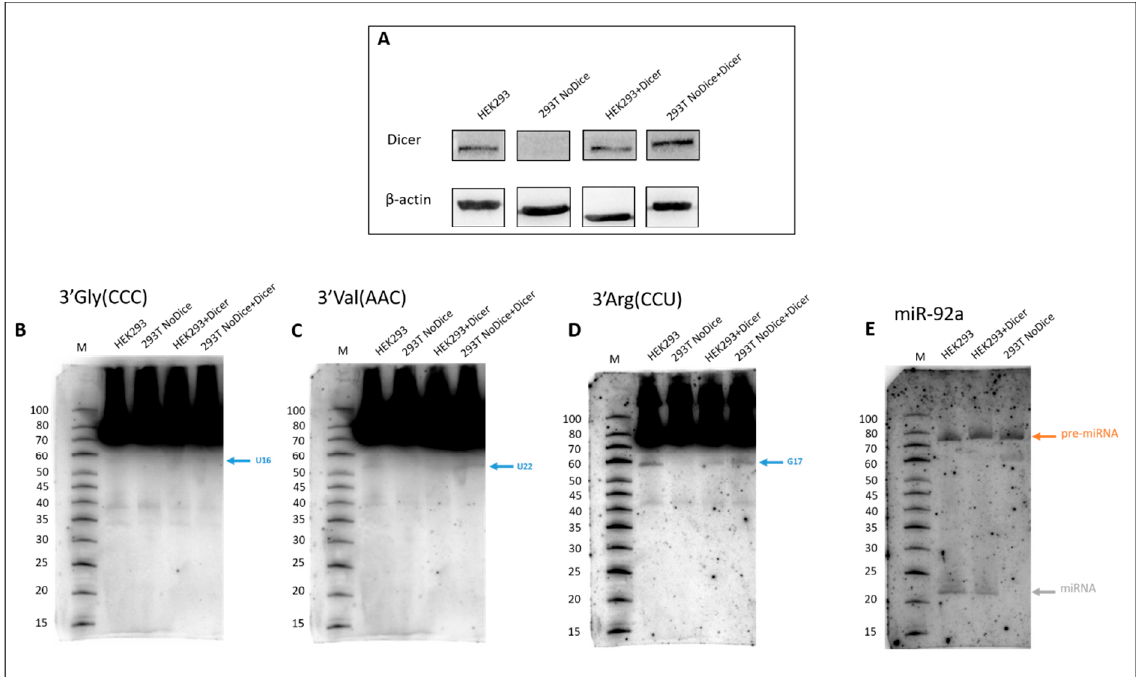
Figure 6. The impact of Dicer overexpression on the biogenesis of tRNA-derived fragments. ( A ) Western blot detection of hDicer nuclease expression in wild-type HEK-293T and 293T NoDice cells, before and after transfection with a plasmid producing hDicer. Cells were harvested 48 h after transfection with the plasmid producing the wild-type full-length hDicer and subsequently lysed and analyzed by Western blotting with anti-Dicer antibodies. β -actin was used as a loading control. Dicer’s influence on the cleavage of tRFGly(CCC) ( B ), tRF(AAC) ( C ) and tRFArg(CCU) ( D ). Cleavage sites in the D loop have been marked with a blue arrow. ( E ) miR-92A biogenesis in wild-type HEK-293T and 293T NoDice cells and HEK-293T cells after transfection with the plasmid producing hDicer. Pre-miRNA and mature miRNA are marked with orange and grey arrows, respectively.